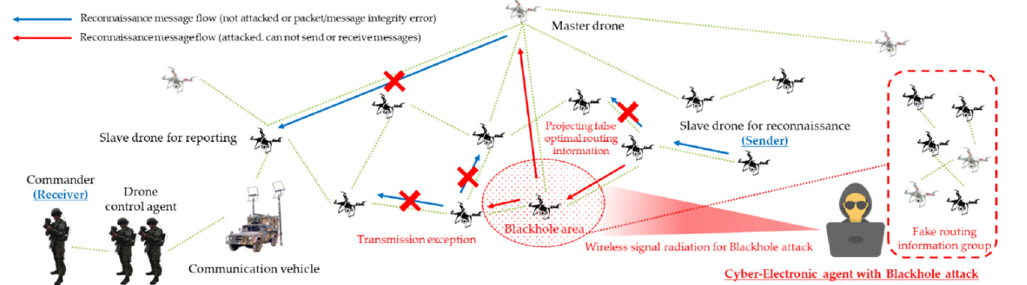
Figure 11. Blackhole attack scenario for reconnaissance report in swarming communication drones maneuvering system.